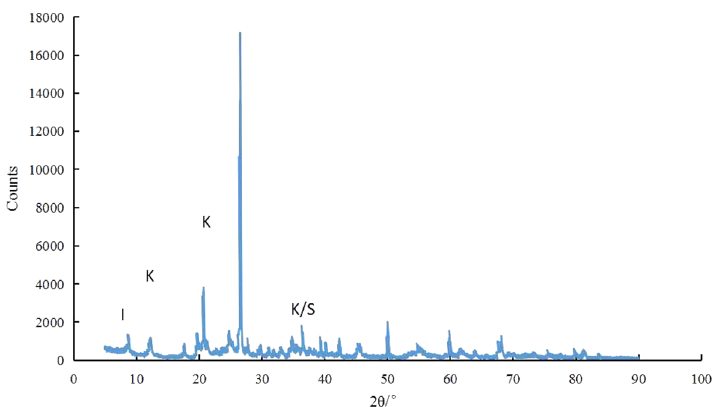
Figure 1. X-ray diffraction of expensive